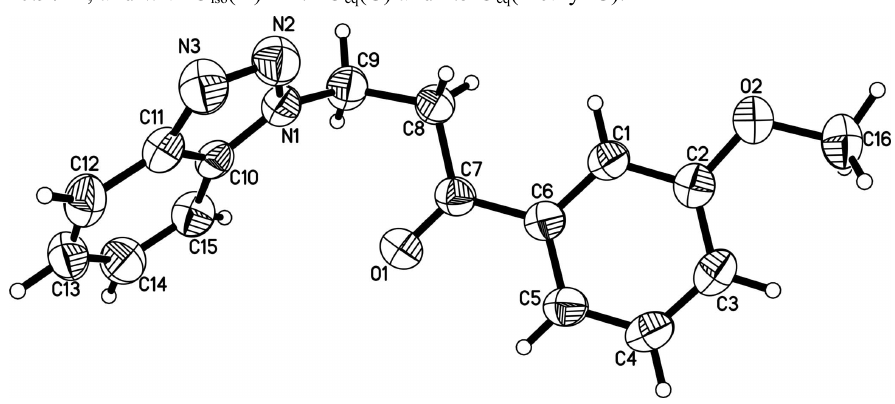
Figure 1 The molecular structure of (I) showing 50% probability displacement ellipsoids and the atom numbering